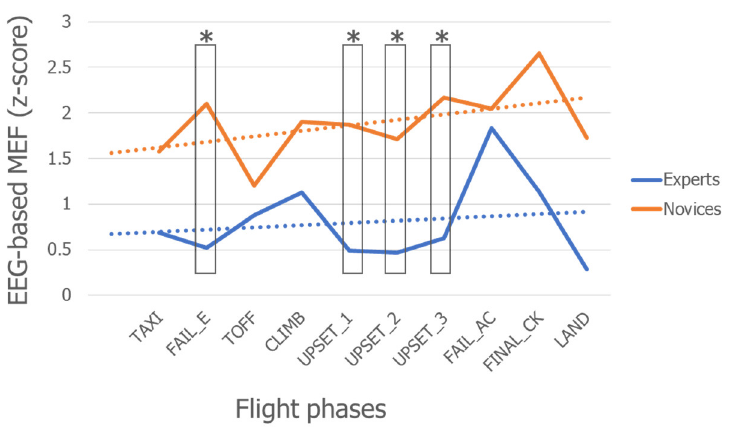
Figure 7. Median EEG-based mental effort (MEF) index values throughout the flight phases of the Experts (blue line) and Novices (orange line). The corresponding dotted lines are the interpolated linear trends. Significant differences (all p < 0.05) were found for the resolution of the FAIL_E and recovery of UPSET_1, UPSET _2 and UPSET _3 conditions. The black boxes group the conditions exhibiting statistical differences, while the asterisk means that the differences were statistically significant ( p < 0.05).